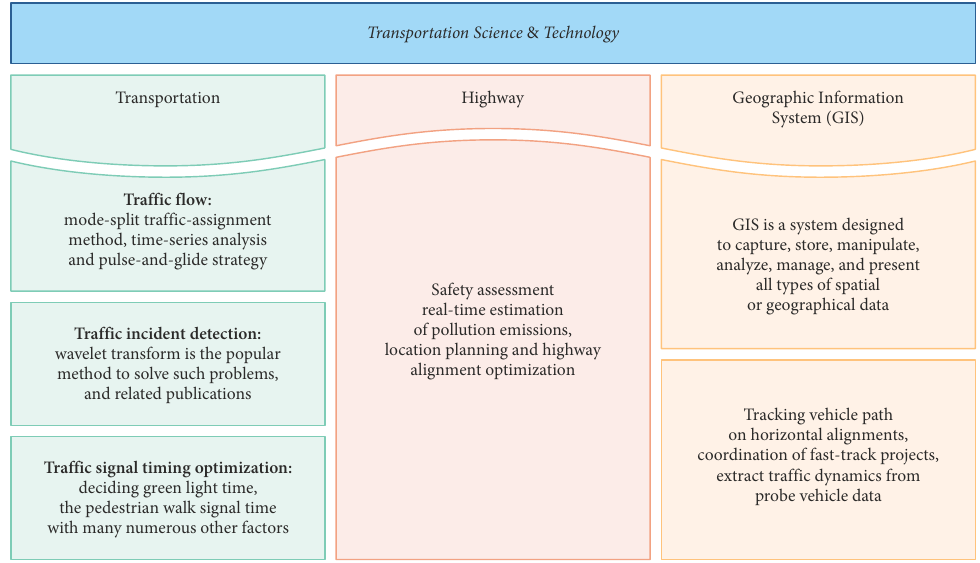
Figure 15. Publications in the field of Transportation Science &